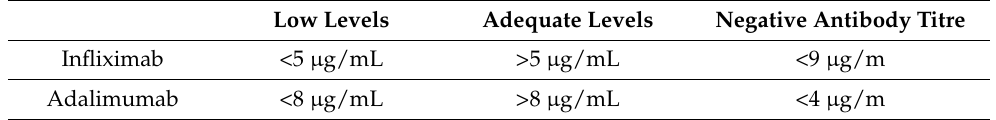
Table 3. Monitoring anti-TNF treatment.